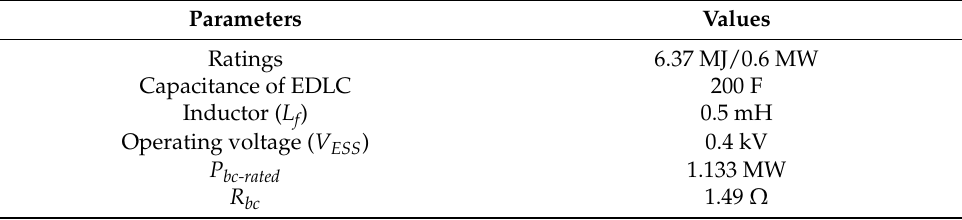
Table 3. Specifications of ESS and